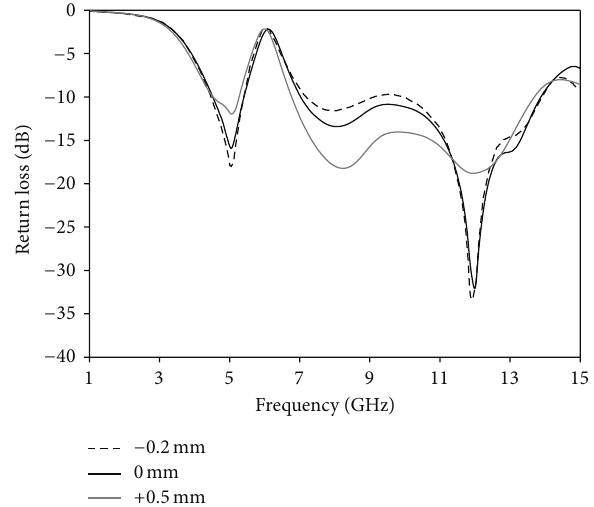
Figure 9: Effects on return loss with changing 𝑠